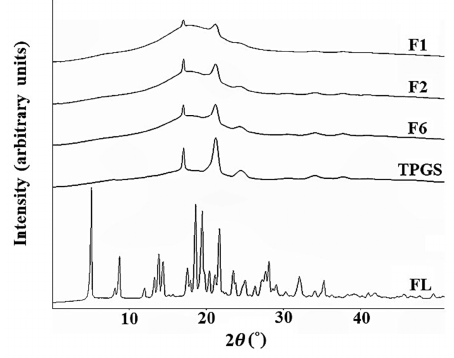
Figure 3. Powder X-ray diffraction (PXRD) curve of F1, F2, F6, TPGS and FL.